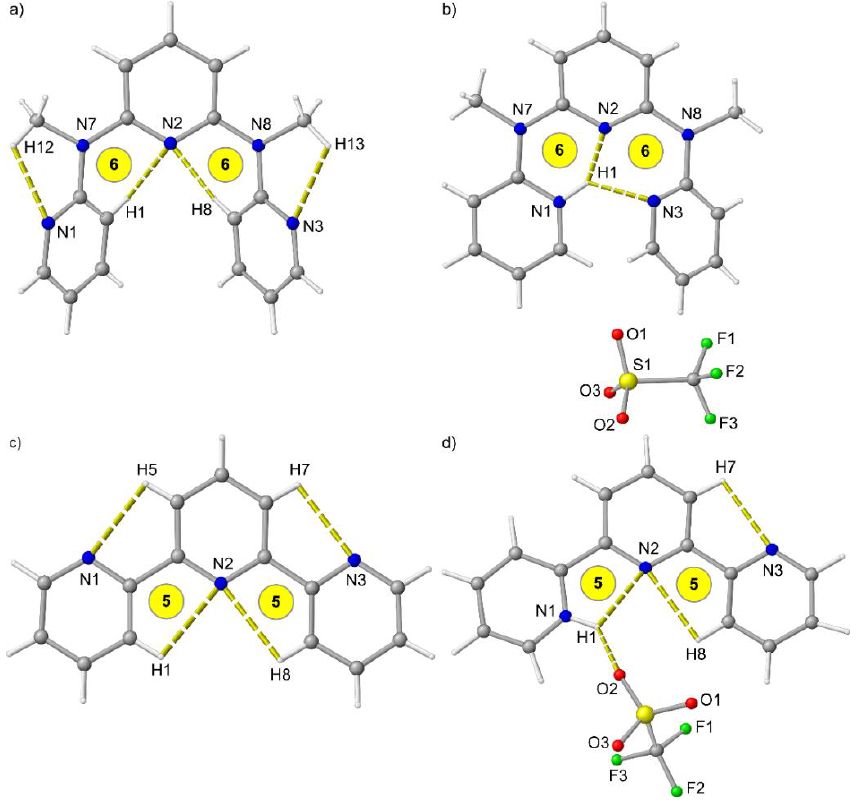
Figure 1. Molecular structures of ( a ) ddpd, ( b ) [H-ddpd][CF 3 SO 3 ], ( c ) tpy [44] and ( d ) [H-tpy][CF 3 SO 3 ] [48] in the solid state. Hydrogen bonds indicated by yellow dashed lines. Atom numbering unified for clarity. Ring sizes involving the central pyridine highlighted in yellow.